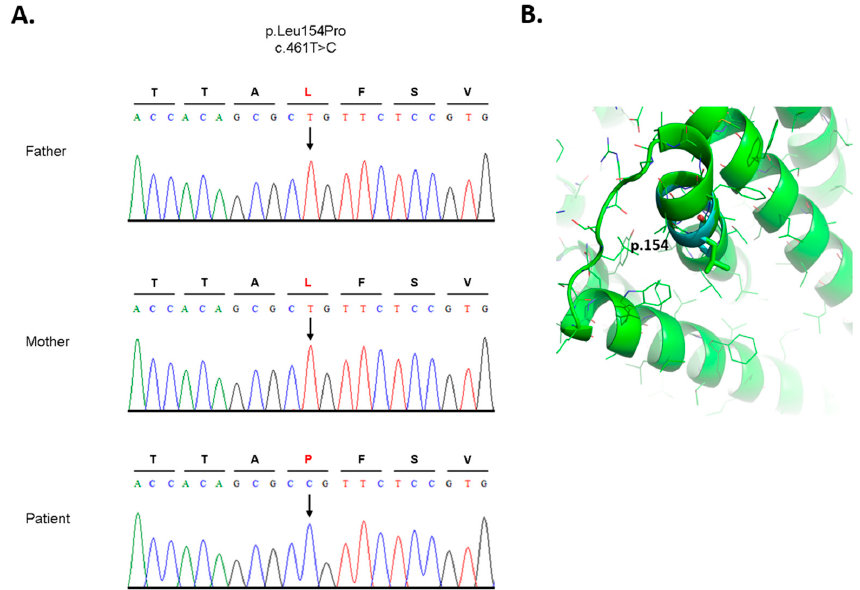
Figure 3 . ( A ) Sanger sequencing analysis of the SLC35A2-CDG patient and his parents. Representative sequence chromatograms of unaffected parents and the patient are shown. The protein and cDNA annotations of the identified new variant are shown above. The arrow shows the position of nucleotide exchange of a new variant. ( B ) Tertiary SLC35A2 protein structure. P.154 amino acid selected for in silico mutagenesis p.Leu154Pro and indicated in different colors (atoms are color-coded), leucine—green, superimposed proline—cyan.